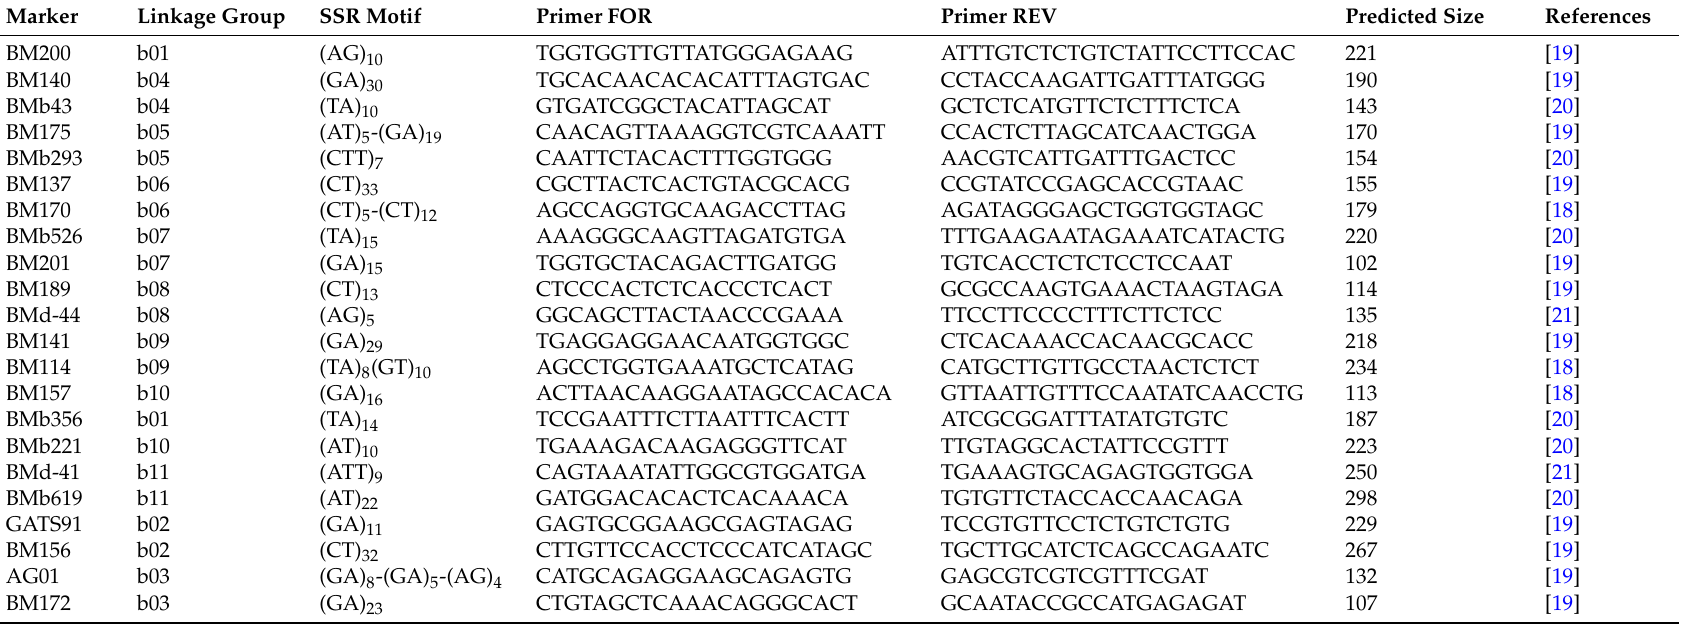
Table 3. List of tested primer